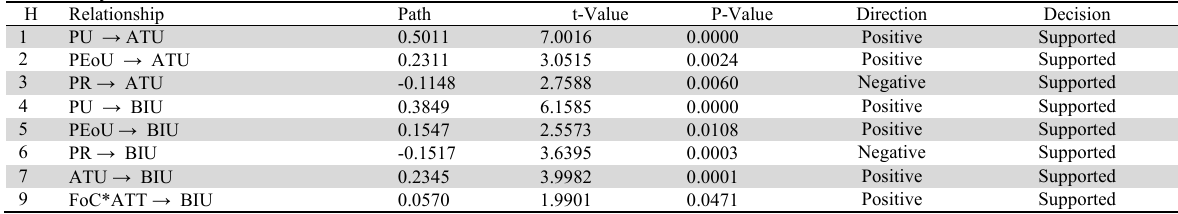
Path Analysis Results, Direct